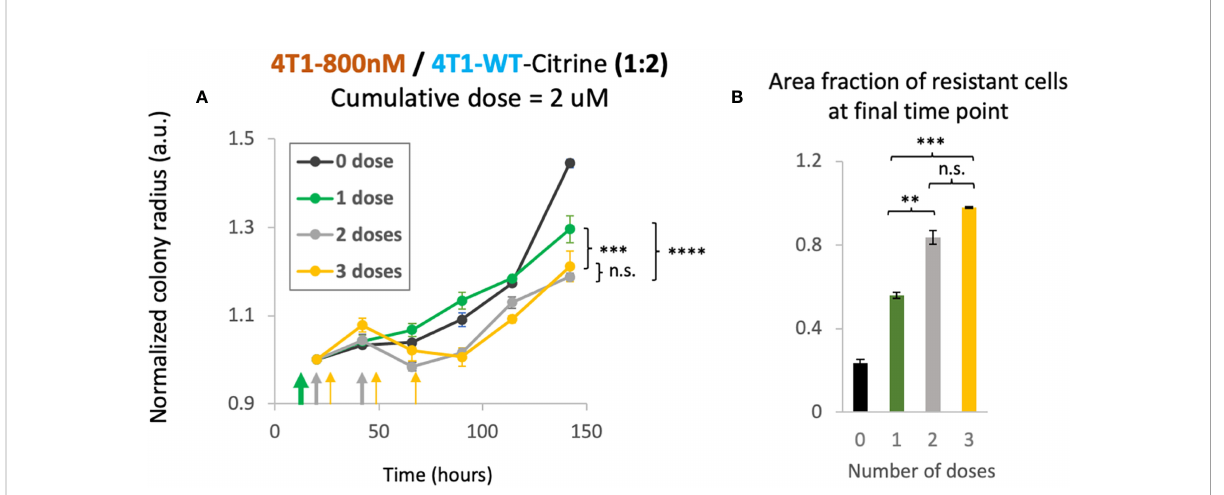
FIGURE 5 Cumulative treatment regime and long-term overall ef fi cacy. (A) Normalized colony radius as a function for cumulative doses of 2 m M split into 1-3 administrations (green, grey and yellow arrows). Mixed colonies of 4T1-Dox [800nM] and 4T1-WT were seeded with a 1:2 ratio. Cumulative dosage for each chemotherapeutic schedule is de fi ned as dosage level (in nM) multiplied by duration of drug treatment (dosing frequency [1/ day] × n days, n = 1, 2 or 3). (B) Area fraction of resistant cells at fi nal timepoint (142 hours) was calculated from area of the mixed colonies occupied where all cells were stained with Hoechst and doxorubicin-sensitive cells expressing Citrine. Resistant fractions = (Hoechst – Citrine)/ Hoechst. Number of replicates, n = 3, and the standard error is calculated with standard deviation divided by the square root of n. 2-way Anova was carried out to calculate the signi fi cance in panel (A) , p value. ** = p<0.01, *** = p<0.003, **** = p< 2 x 10 -6 . n.s., not signi fi